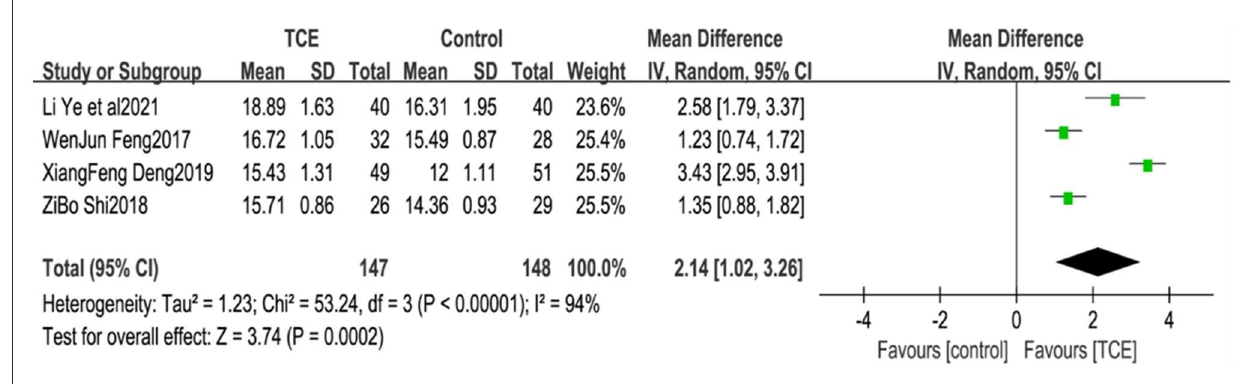
FIGURE6 The effect of Traditional Chinese exercises on patients’ VO2max.